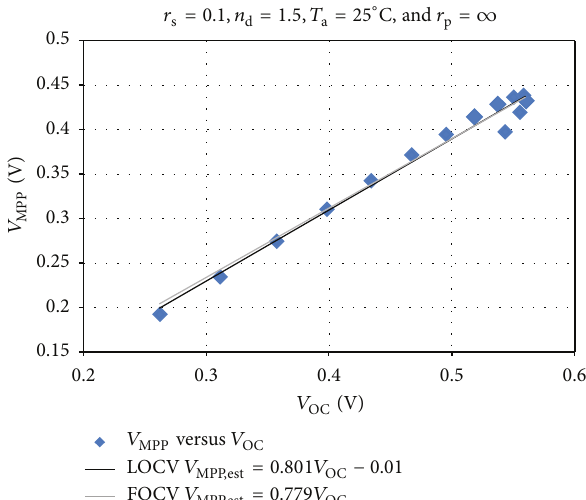
versus 𝑉 for a single PV cell with MPP OC = 1.5 , 𝑟 = 0 , and 𝑟 = 10 . Two regression d s p